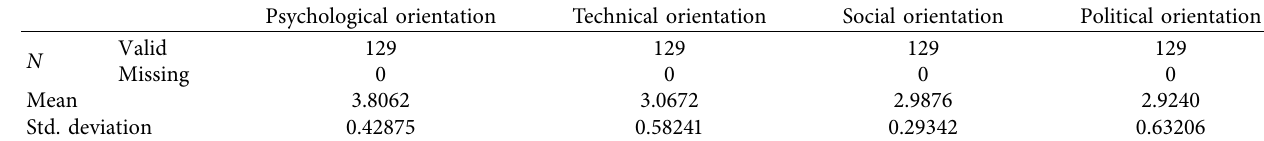
Table 2: Levels of teachers’ beliefs about autonomy orientations.